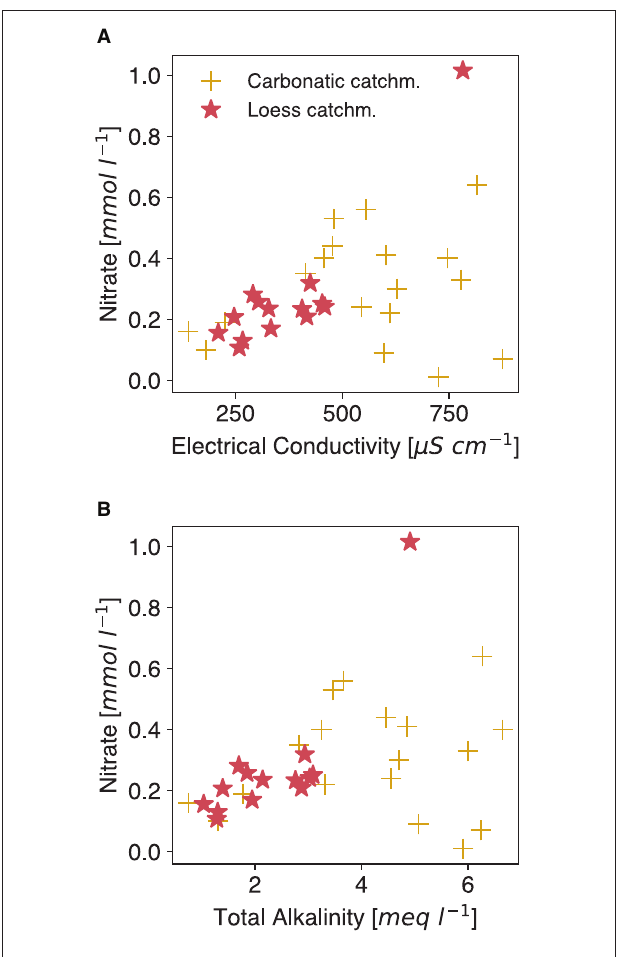
FIGURE 4 | Relation between nitrate and electrical conductivity (A) and total alkalinity (B) . Data from rivers draining carbonatic catchments from Perrin et al. (2008) and loess catchment data as in Figure 3B . Both datasets contain water from catchments which are influenced by agricultural